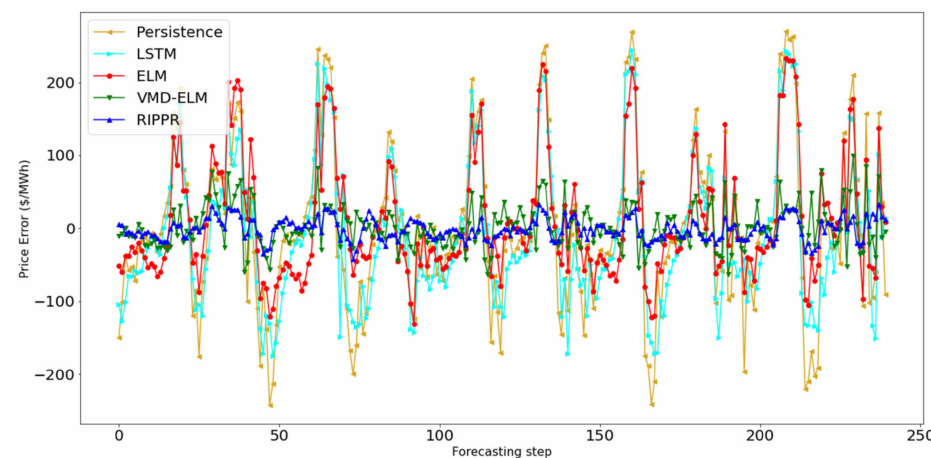
Figure 8. Forecasting error-six steps ahead forecasting for dataset A.